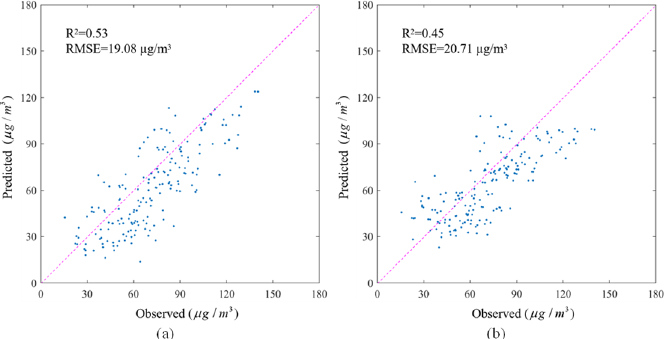
Figure 7. Scatter plots for ( a ) hybrid model and ( b ) BME model at locations more than 100 km from the nearest monitoring site.